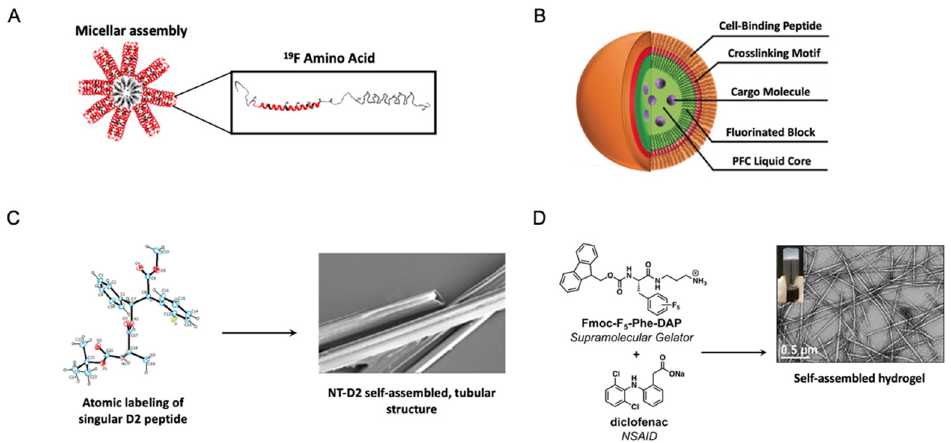
Figure 15. Illustrations of various self-assembled fluorinated protein and peptide drug delivery vehicles. ( A ) Micellar assembly. Adapted with permission from [81]. Copyright 2019 American Chemical Society. ( B ) Nano-peptisome assembly. Adapted with permission from [86]. Copyright 2017 Wiley-VCH Verlag GmbH & Co. KGaA, Weinheim. ( C ) Nanofibers constructed from repeating D2 peptides. Adapted with permission from [82]. Copyright 2015 American Chemistry Society. ( D ) Hydrogel assembled from Fmoc-F 5 -Phe-DAP and loaded with diclofenac, a small molecule non-steroidal, anti-inflammatory drug (NSAID). Adapted with permission from [84]. Copyright 2019 American Chemical Society.